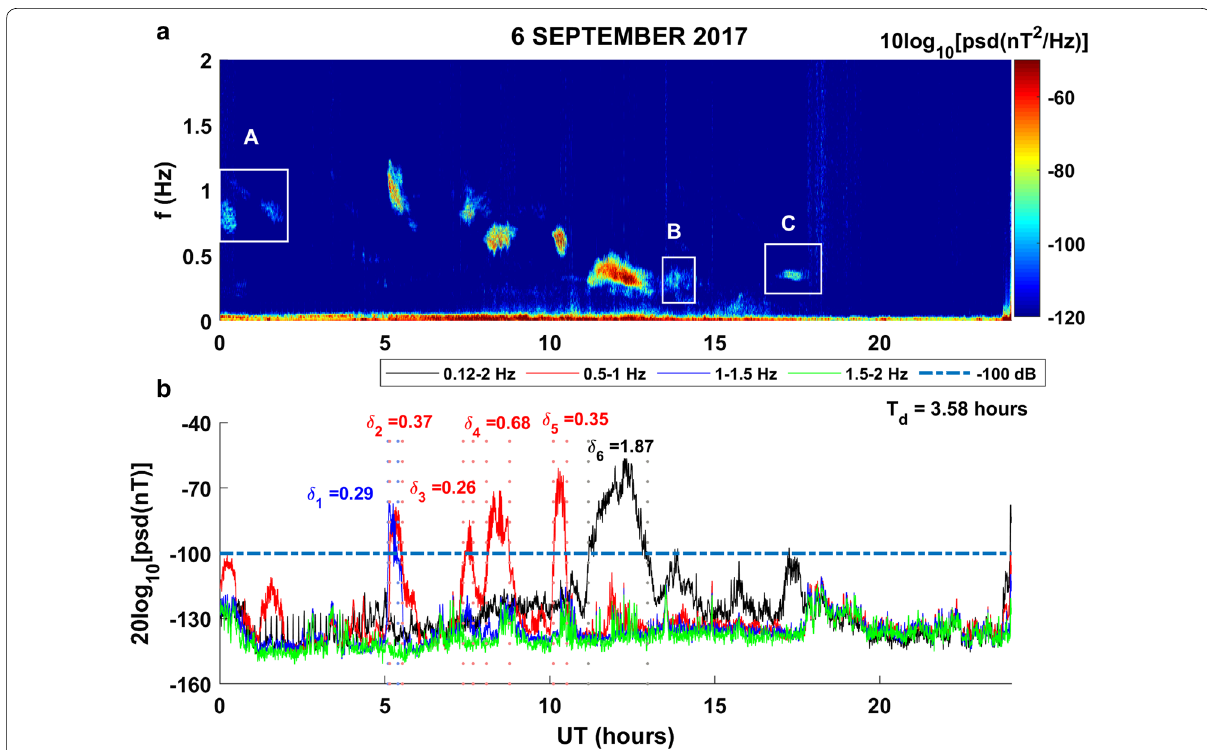
Fig. 2 a The spectrogram of the total magnetic field variation, and b corresponding plot of averaged powers for different frequency bins are depicted as a function of universal time (UT LT-0.77 h) for EMIC wave activity observed on 6 September 2017. The intervals of EMIC wave activity = are mentioned in the lower panel and they are marked with black, red and blue dotted vertical lines for f 1 , f 2 and f 3 frequency bins, respectively. The δ 1 − 6 represent the durations of EMIC waves in these three frequency bins. The total EMIC duration for this day is 3.58 h. The white boxes marked by letters A, B and C represent EMIC wave events with very low